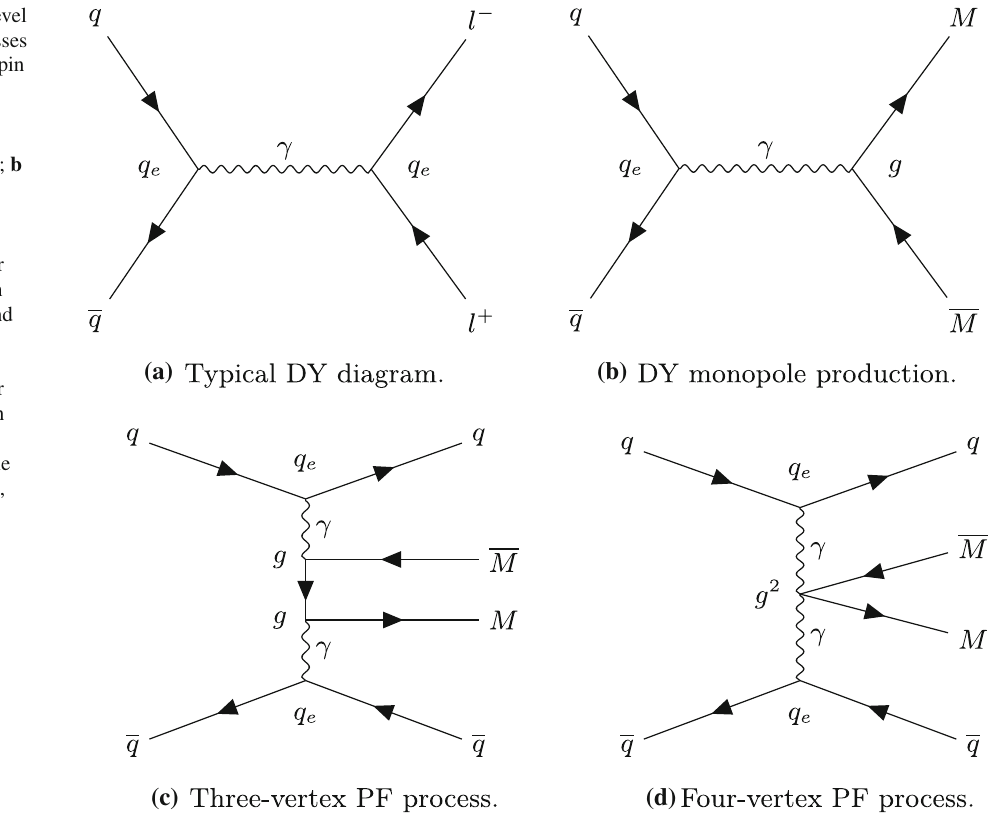
Fig. 1 Feynman-like tree-level graphs for production processes of monopoles with generic